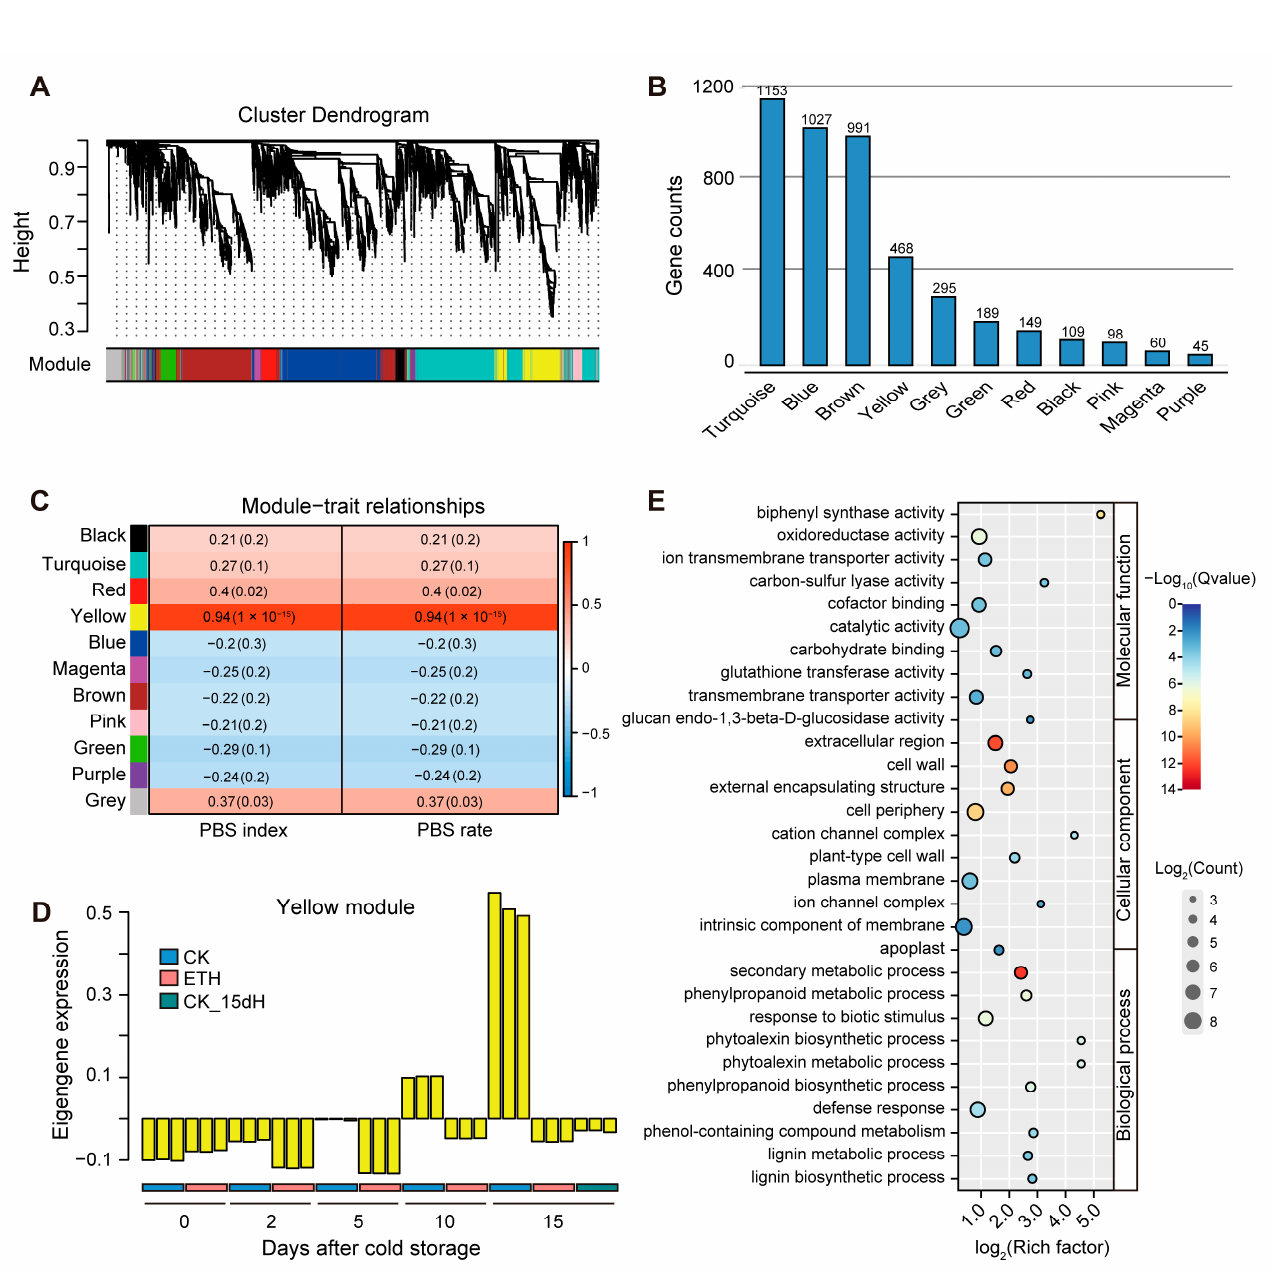
Figure 5. Weighted gene co-expression network analysis (WGCNA) and GO enrichment analysis. ( A ) Construction of WGCNA modules. ( B ) Gene counts in each module. ( C ) Module–trait relation- ships. Numbers in each grid are Pearson correlation coefficient and significant p -value in brackets. ( D ) Eigengene expression in the ‘Yellow’ module. ( E ) GO enrichment analysis of the ‘Yellow’ module. Module–trait relationships analysis showed that the “Yellow” module was strongly and positively correlated with the PBS index and PBS rate ( r = 0.94, p = 1 × 10 -15 ) (Figure 5C). The eigengene expression profile of the “Yellow” module showed that genes in this